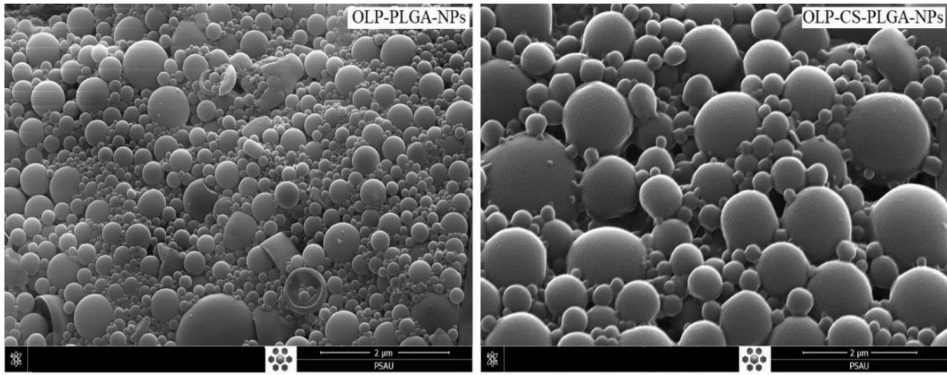
Figure 4. SEM images of OLP-loaded PLGA NPs and OLP-loaded CS-PLGA NPs.